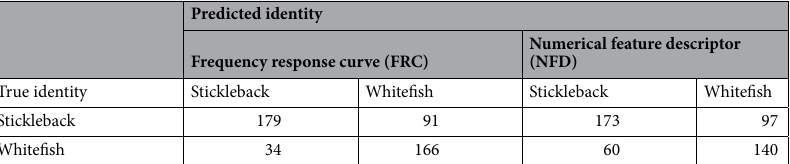
Table 2. A confusion matrix showing species classification of targets from the testing data set using two prediction approaches, frequency response curve (FRC) and numerical feature descriptor (NFD). Each cell contains the number of known stickleback or whitefish responses (rows) that were predicted to belong to either stickleback or whitefish